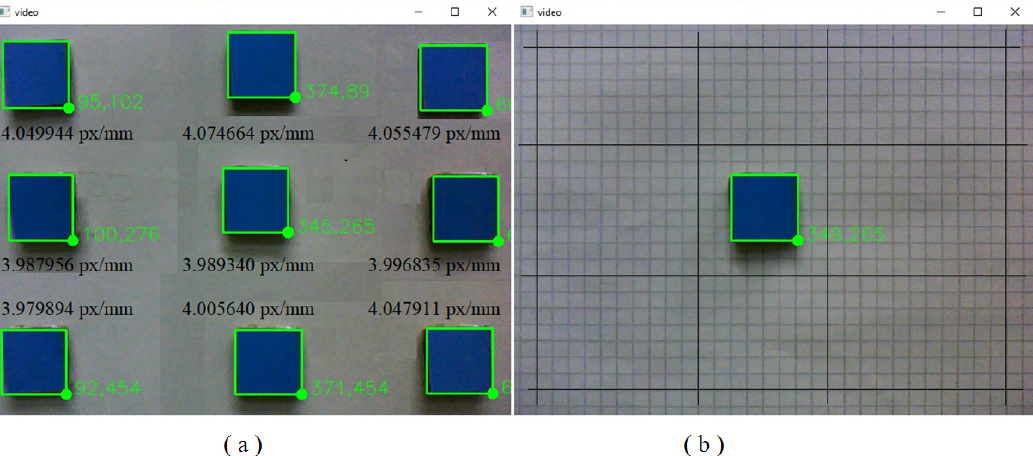
Figure 7. ( a ) Pixel density in separate locations of the video frame, μ = 4.020851, σ = 0.035767, COV = 0.008895. ( b ) Using a sheet grid to visualize optical distortions (barrel, pincushion, and wavy distortion). The green coordinates refer to the pixels ( x, y ) in the right-low corner of the target. The coordinates increased from the upper-left corner of the video frame. μ is the arithmetic media, σ is the standard deviation, and COV is the coefficient of variation.